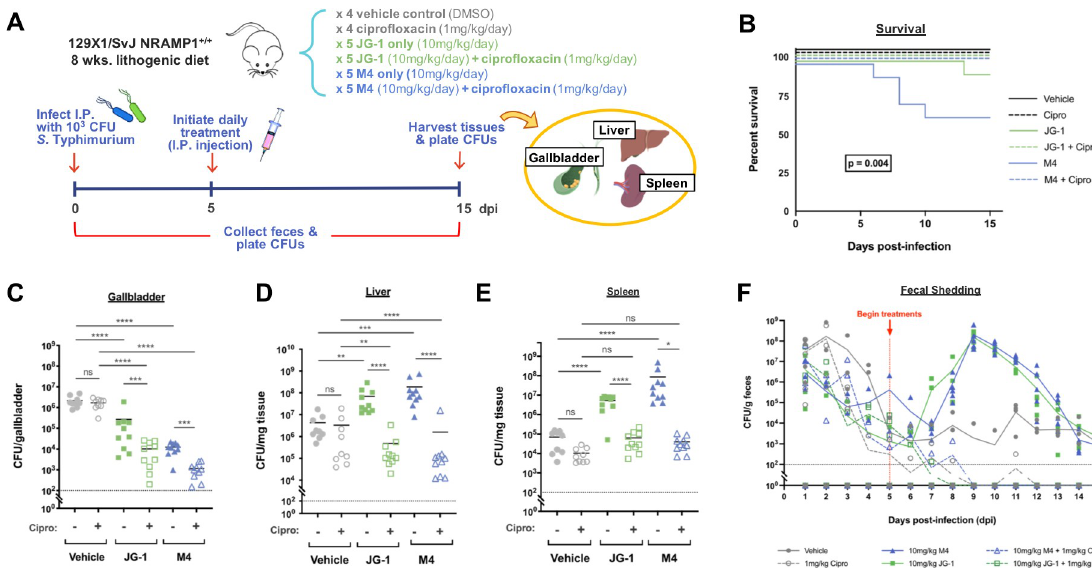
Fig 5. Combination with ciprofloxacin (cipro) enhances the safety and efficacy of JG-1 and M4 in a mouse model of chronic gallbladder carriage of Salmonella . A. Experimental design: 129X1/SvJ mice were fed a lithogenic diet for 8 wks. prior to I.P. infection with 10 3 S . Typhimurium. Starting 5 days post-infection (dpi) and continuing through 15 dpi, mice received daily I.P. treatments of cipro, JG-1, M4, JG-1 + cipro, M4 + cipro, or a vehicle control. CFU enumeration was used as a means of evaluating bacterial burden in various organs at 15 dpi as well as fecal shedding of Salmonella throughout the course of infection. B. Survival analysis of Salmonella- infected mice receiving various treatments. Kaplan Meier survival estimates were evaluated for overall variance using the logrank test. Post hoc pairwise comparisons of M4 and JG-1 curves were performed using the logrank test with the Bonferroni correction for multiple comparisons (adjusted threshold for significance: p < 0.025). C–E. Enumeration of Salmonella in the gallbladder (C) , liver (D) , and spleens (E) of infected mice on 15 dpi. ns non-significant, � p < 0.05, �� p < 0.01, ��� p < 0.001, ���� p < 0.0001. F. Fecal burden of Salmonella in infected mice monitored from 0 (prior to infection) to 15 (prior to sacrifice) dpi. Images created with BioRender.com.